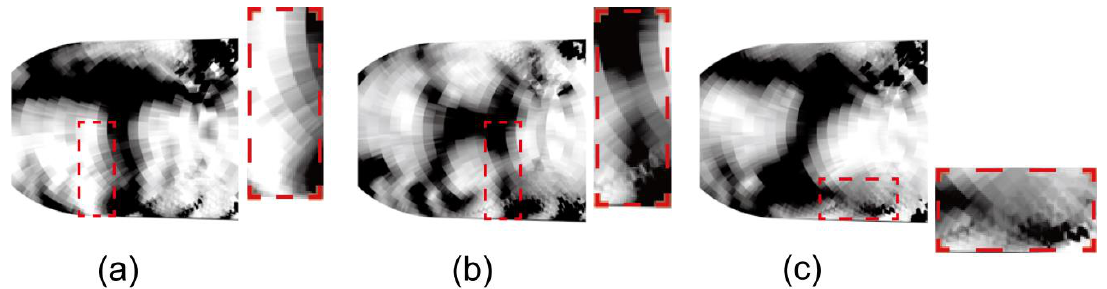
Figure 9. THz images of ( a ) sample 1, ( b ) sample 2, and ( c ) sample 3 obtained from the THz rotation mirror imaging experiment.